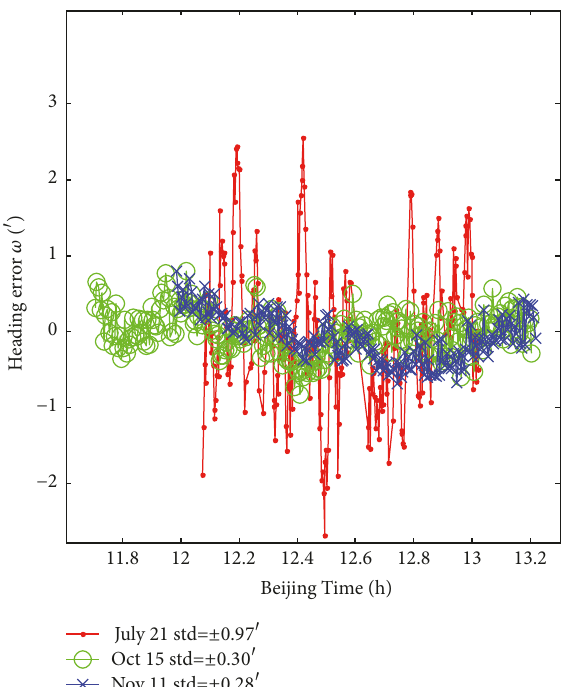
Figure 12: Time series of the heading errors.